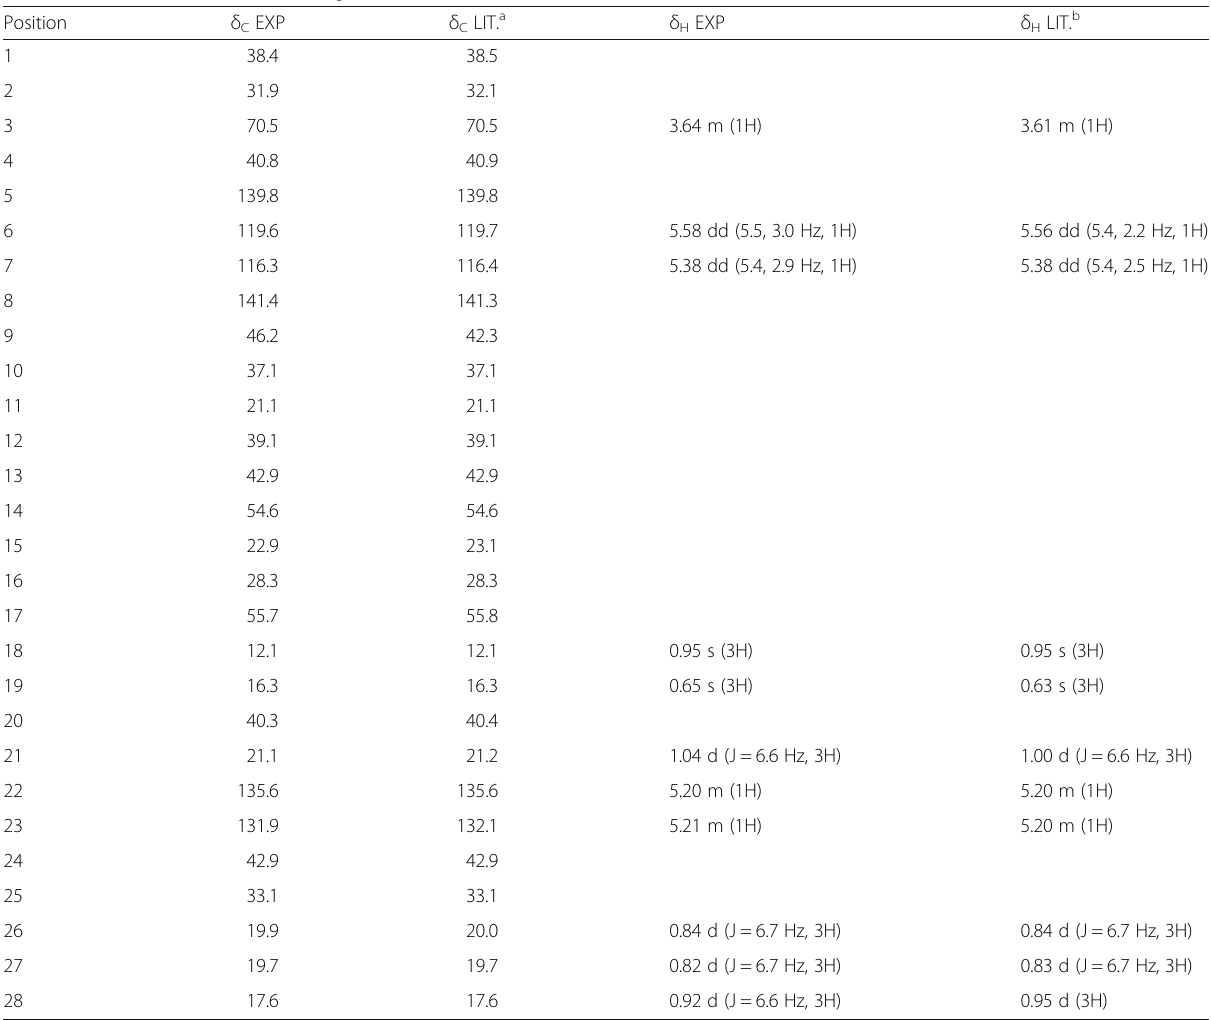
Table 2 13 C and 1 H RMN data for ergosterol (75 MHz and 300 MHz)